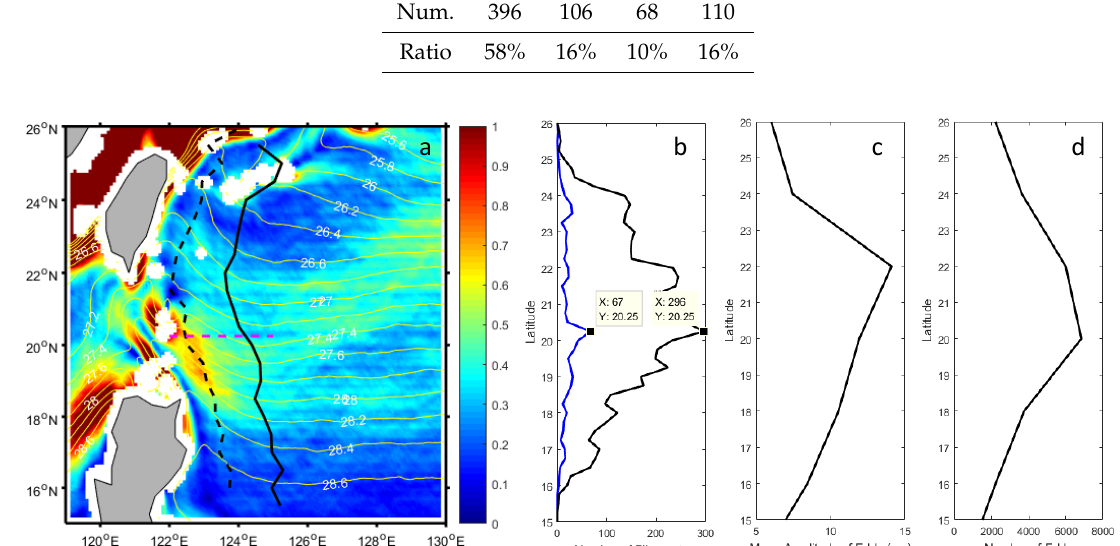
Figure 8. ( a ) SST ( ◦ C, yellow contours) and SST gradient ( ◦ C/ ◦ longitude, color shading) for the SST climatology. The dashed (solid) black line is the average occurrence (end) points of warm filaments for each 0.25 ◦ meridional grid. The dashed magenta line marks latitude 20.25 ◦ N. ( b ) Distribution of the number of warm filaments that appear (black line) and occurrence probability (blue line) in each 0.25 ◦ latitude bin. ( c ) Distributions of mean eddy amplitudes (cm) for each 2 ◦ latitude bin based on the mesoscale eddy atlas produced by SSALTO/DUACS and distributed by AVISO+ (https: //www.aviso.altimetry.fr/). ( d ) Distributions of the number of eddies for each 2 ◦ latitude